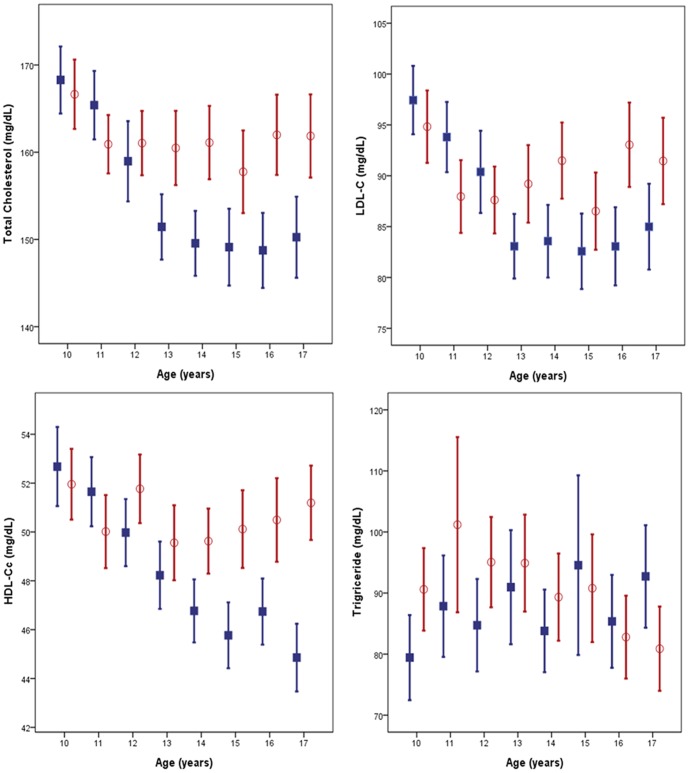
Change of each lipid concentration aged 10 to 18 years (Mean and 95% CI).Blue line and filled square represent boys and Red line and empted circles represent girls. Abbrevation: LDL-C, Low-density lipoprotein cholesterol ; HDL-C, High density lipoprotein cholesterol;.